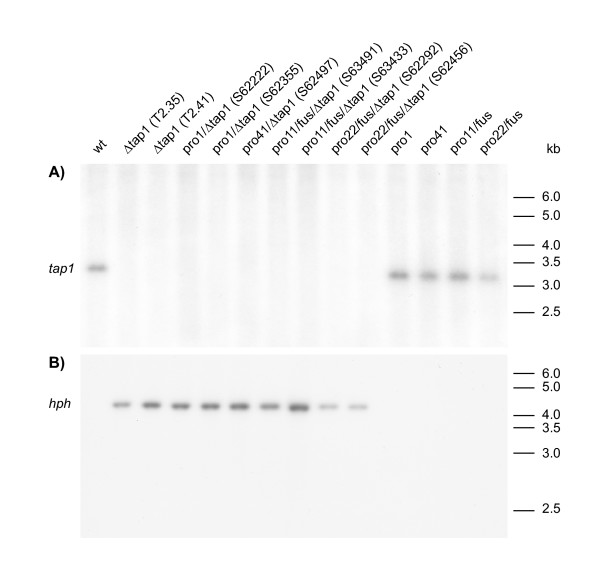
Southern blot analysis of Δtap1 strains. Genomic DNA from the wild type, from two different Δtap1 single spore isolates from the original knockout strain, and from double mutants of Δtap1 with pro1, pro41, pro11, and pro11 was hydrolyzed with BglII, and after gel electrophoresis, the Southern blot was probed with radio-labeled DNA fragments containing the open reading frames of tap1 (A) and hph (B), respectively. Marker sizes in kb are provided on the right. Numbers in brackets are strain numbers for single spore isolates.